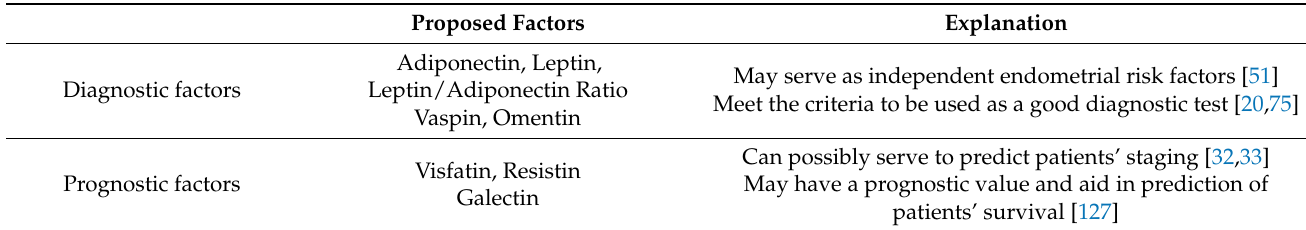
Table 3. Potential diagnostic and prognostic factors for patients with endometrial